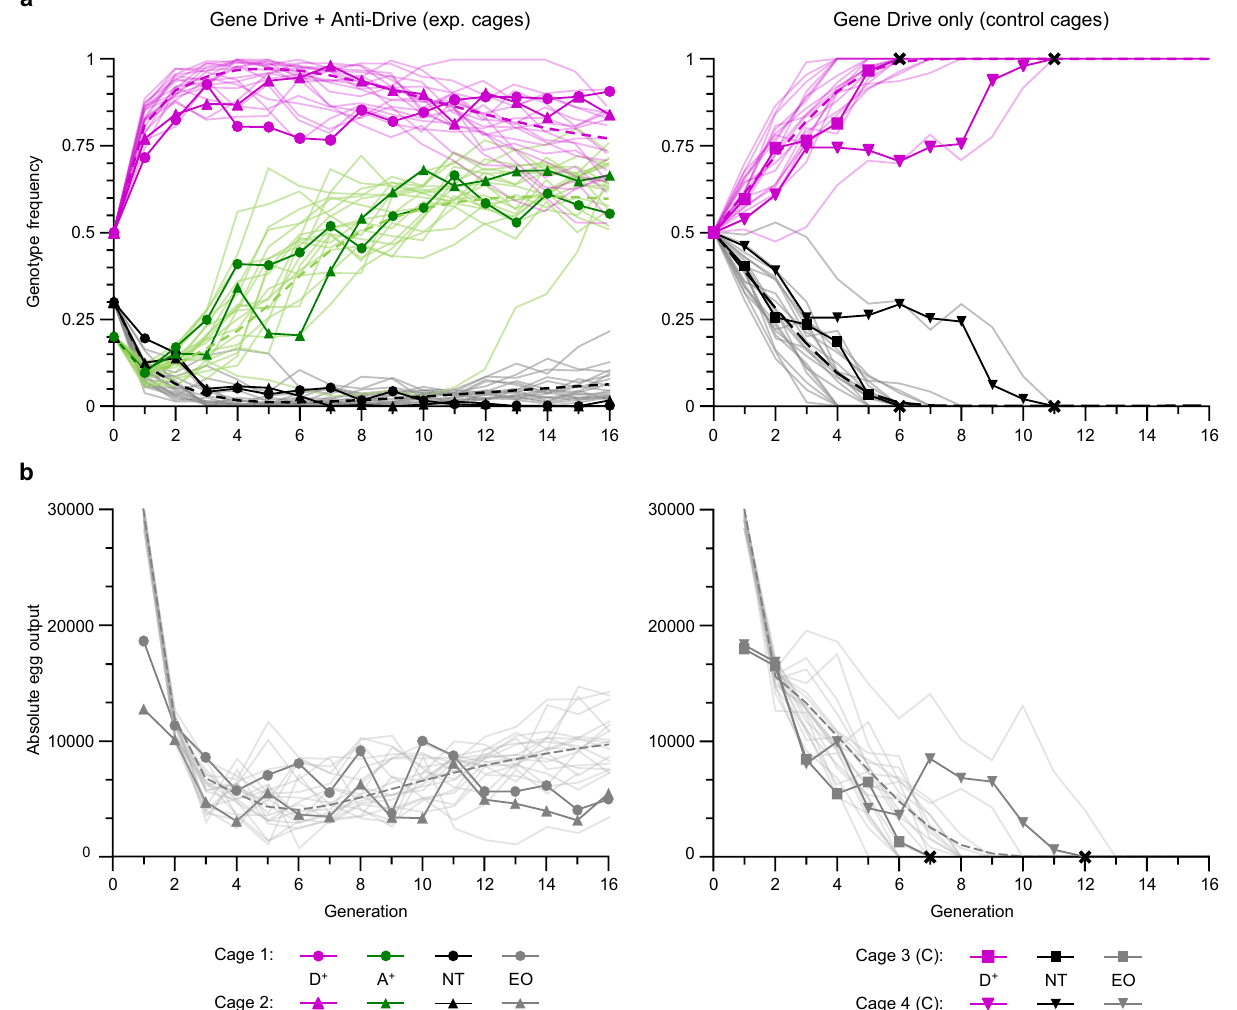
Fig. 3 A single release of AcrIIA4 anti-drive males constrains gene drive spread preventing population suppression in caged mosquitoes. Two cages were initiated with a starting population of 600 A. gambiae mosquitoes of which 150 males and 150 females heterozygous for the zpg:dsxF driving allele (initial drive allele frequency of 25%), 120 homozygous-enriched males for the vasa:A4 allele (initial anti-drive allele frequency of 20%) and 180 wild-type of which 30 males and 150 females to maintain equal sex ratio (left). In parallel, two control cages were established by releasing the same proportion of drive alleles (150 zpg:dsxF + / − males and 150 zpg:dsxF + / − females) and 300 wild-type mosquitoes (150 males and 150 females). a The frequency of RFP positive drive (D + , dark purple solid lines), GFP positive anti-drive (A + , dark green solid lines) and non-transgenic individuals (NT, black solid lines) was recorded for each generation by screening larvae for the expression of the respective fl uorescent markers. b Absolute number of eggs produced each generation (dark grey solid lines). Genotype frequencies (D + , A + and NT) and egg output (EO) values were overlapped to the respective deterministic (dotted lines) and stochastic (light-coloured lines) model simulation based on the parameters provided in Supplementary Table 2. The respective raw data are provided in the Source data fi